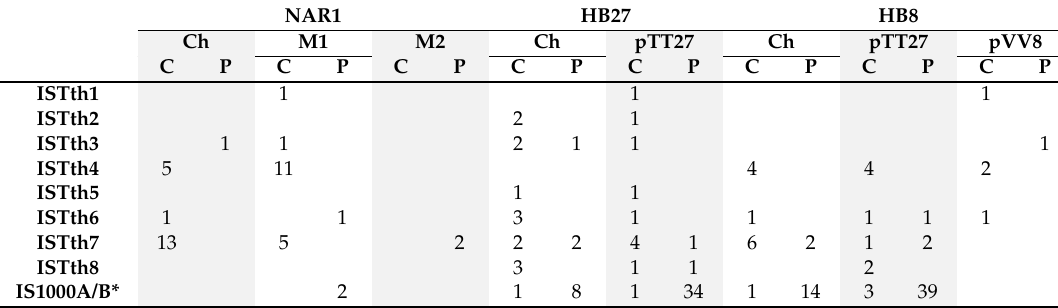
Figure 1. Distribution of insertion sequences (ISs) in Thermus spp. Number of genes annotated as transposases were determined in 18 available genomes at NCBI, RefSeq, and JGI. The genome of T. thermophilus NAR1 is described in this article. The number of IS copies was normalized to the genome size in Mbp; a strain of E. coli was included for comparison. Table 1. Presence of complete (C) and partial (P) IS sequences in the genomes of T. thermophilus strains HB27 (AE017221.1 and AE017222), HB8 (GCA_000091545.1 and AB677526), and NAR1 (PRJEB29203). Distribution among the chromosome (Ch) or the megaplasmids M1 and M2 from NAR1, pTT27 from HB27 and HB8, and pVV8 from HB8 is shown. Note that most partial copies of IS1000A/B actually correspond to CRISPR repeats (see the text for details).*